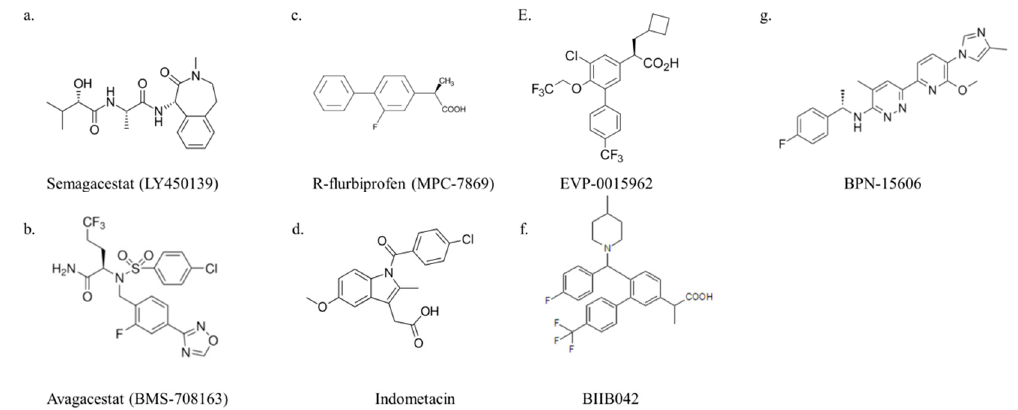
Figure 4. GSI and GSM structures. The GSIs are ( a ) semagacestat and ( b ) avagacestat. The first- generation GSMs are ( c ) R-flurbiprofen and ( d ) indomethacin. The second-generation GSMs are ( e ) EVP-0015962, (f) BPN-15606, and (g) BIIB042.